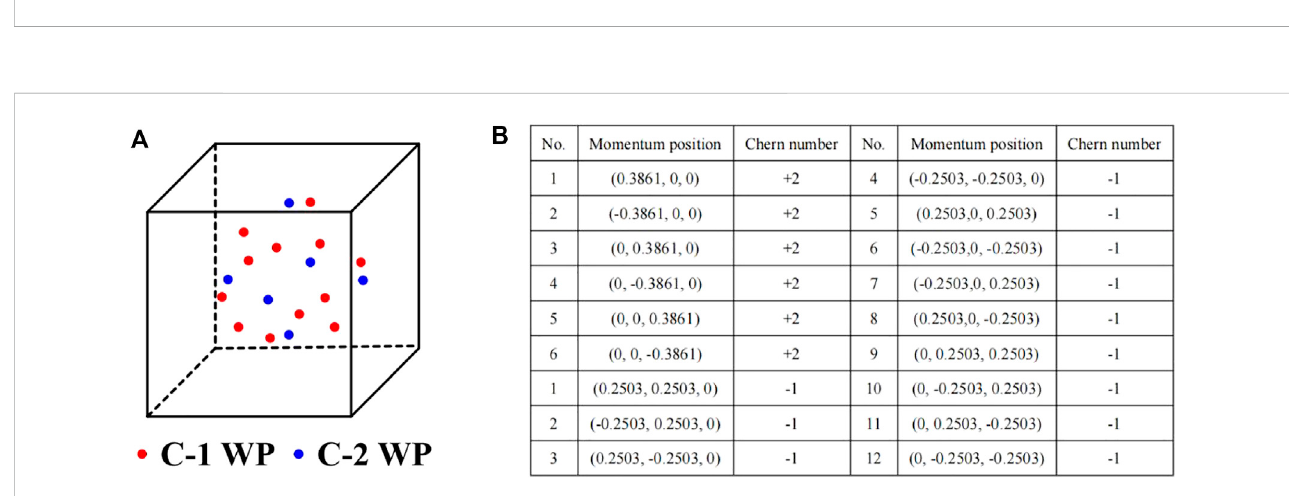
FIGURE 2 (A) and (B) 3DplotsofthephononbandsaroundP1andP2points. (C) and (D) EvolutionsoftheaveragepositionoftheWanniercenterfortheWPwithC= +2 at P1 and the WP with C = − 1 at P2.